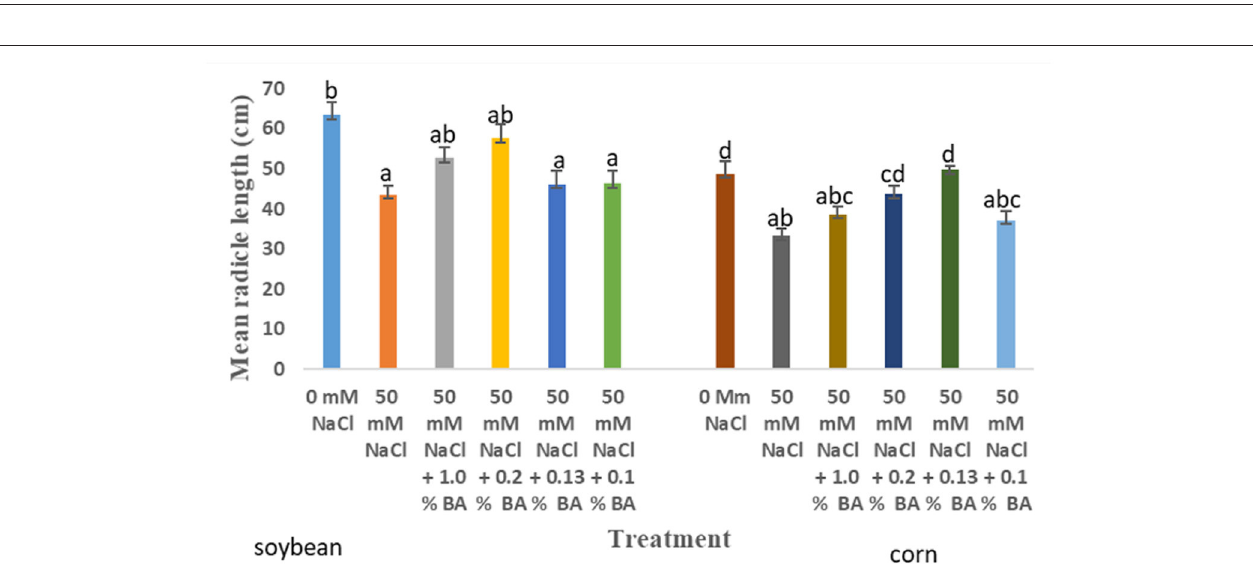
FIGURE 5 | Effect of BA cell-free supernatant on mean radicle length of corn and soybean exposed to 50mM NaCl. Treatments with similar letters are not significantly different. Treatments with different letters are significantly different.